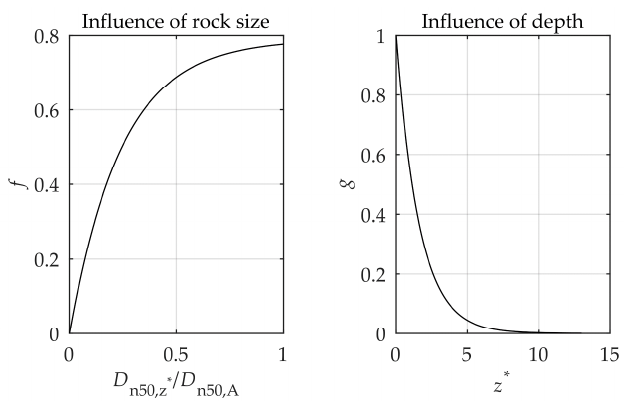
Figure 14. Influence of the relative rock size on ( f ) and influence of relative layer depth on ( g ). The subplots are plotted with the use of Equation (4).